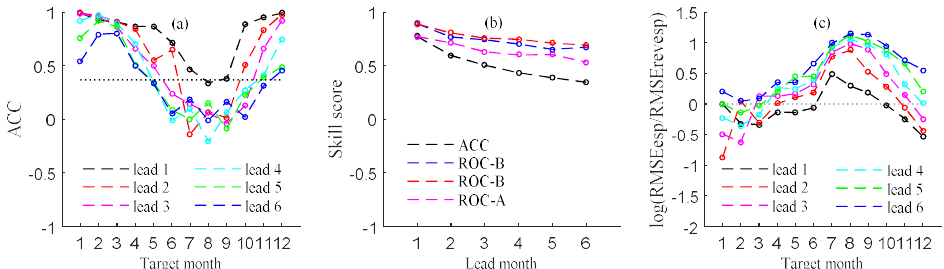
Figure 3. Variation of ( a ) anomaly correlation coefficient (ACC) and ( c ) ratio of forecast to the observation variance with the target month for six lead times, and ( b ) skill scores variation with the lead time in terms of ACC and relative operating characteristic (ROC) areas for the Yellow River.